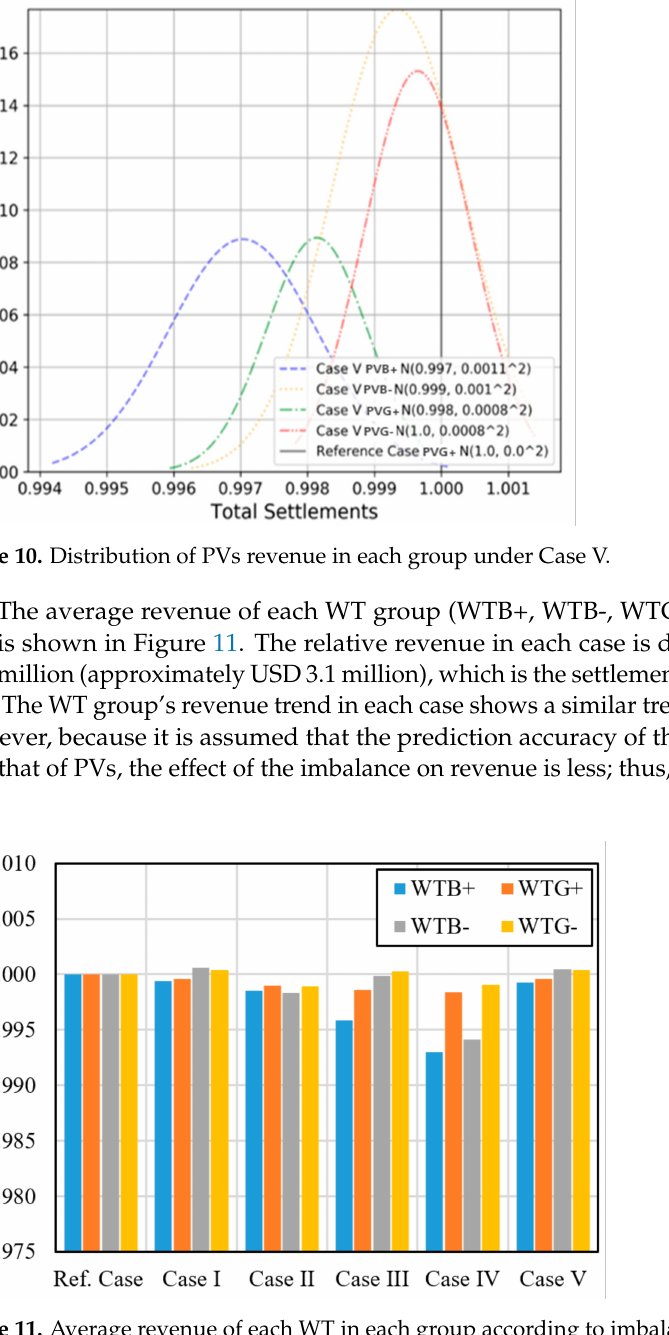
Figure 11. Average revenue of each WT in each group according to imbalance pricing